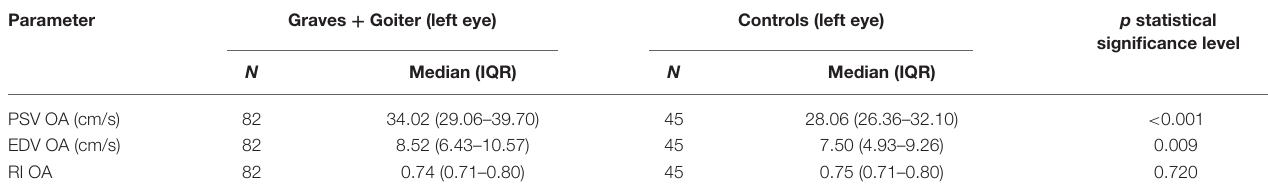
TABLE 6 | Comparison of blood flow parameters (PSV, EDV, RI) in ophthalmic artery in hyperthyroid patients and healthy controls. Parameter